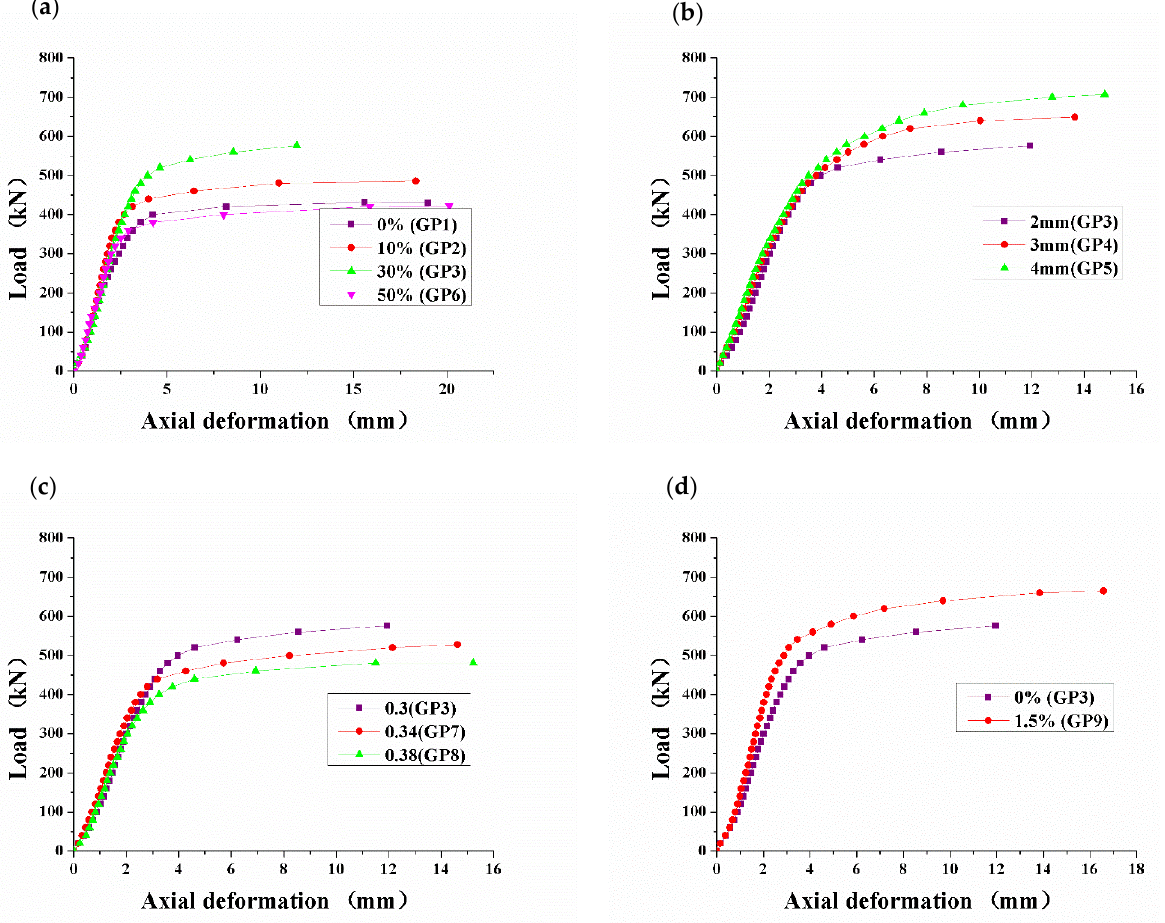
Figure 6. Different influence factors on the axial load–deformation of CFSTs. ( a ) amount of GDS; ( b ) wall thickness; ( c ) W/B; and ( d ) amount of sodium sulfate.